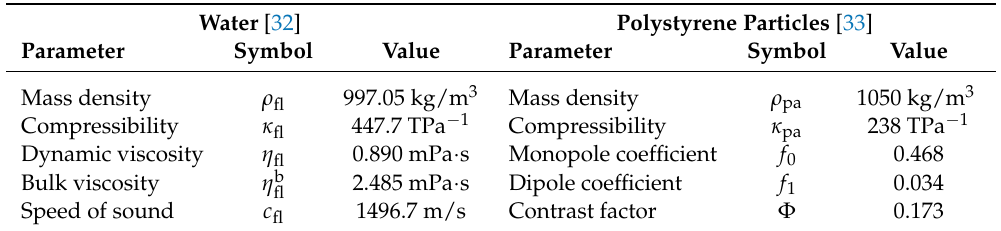
Table A3. Parameters for water and polystyrene tracer particles at 25 ◦ C. The scattering coefficients are calculated in terms of the mass densities and compressibilities as f 0 = 1 − κ pa which in turn gives the acoustic contrast factor Φ = 1